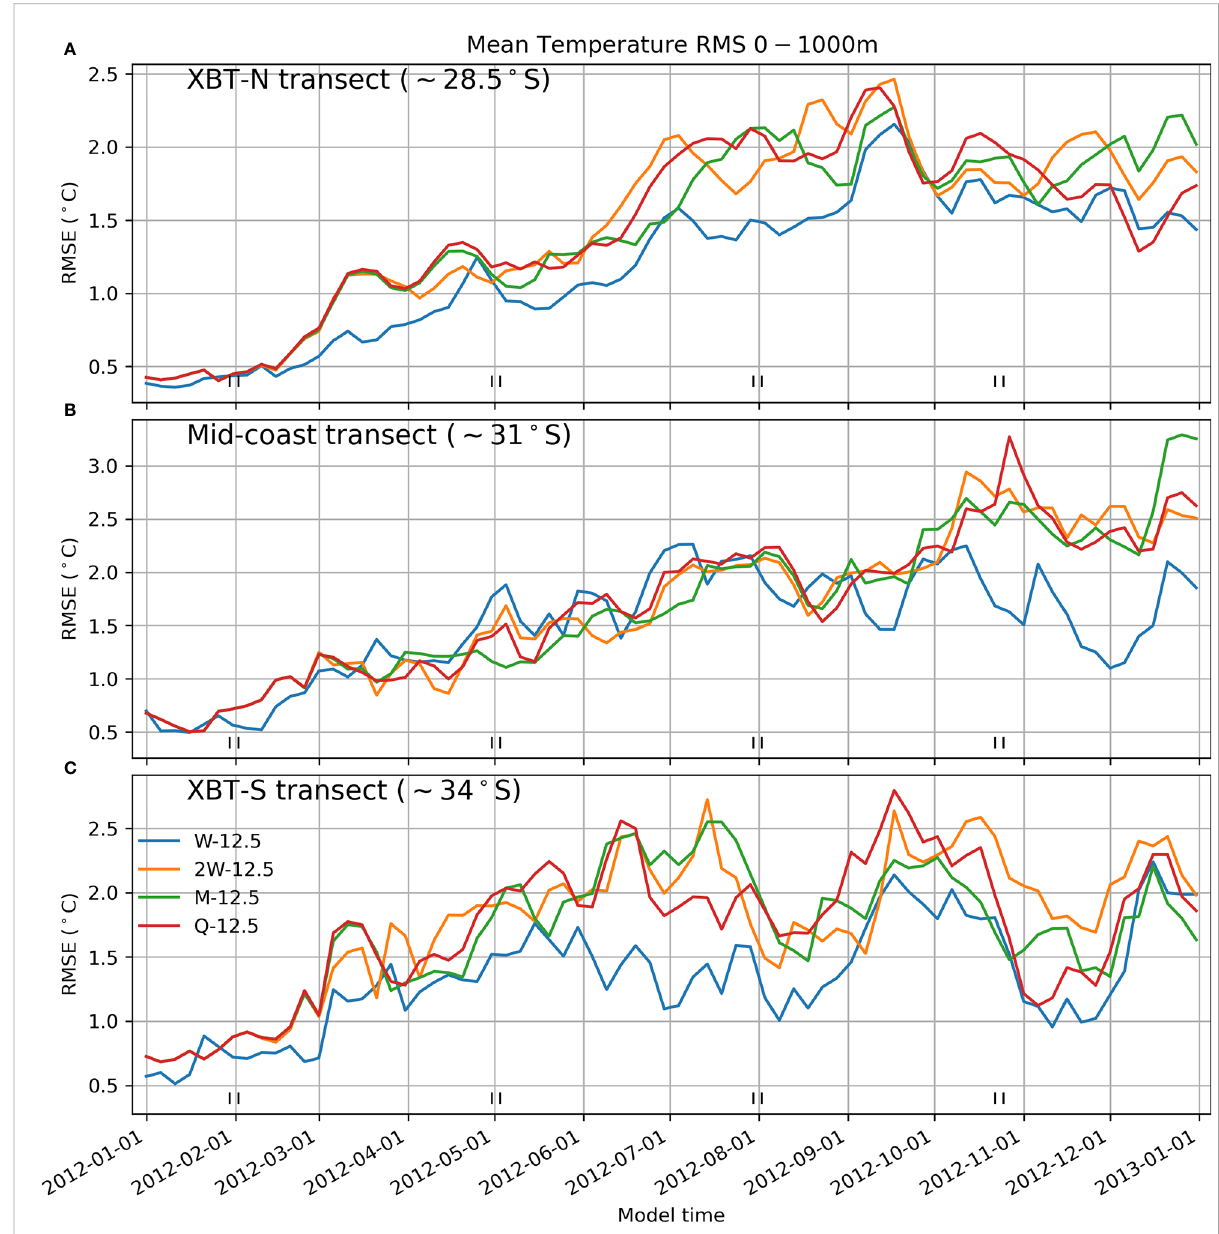
FIGURE 5 The transect-mean RMS error in temperature for (A) the XBT-N transect at ~28.5°S, (B) the mid-coast analysis transect at ~31°S and (C) the XBT-S transect at ~34°S for the four different OSSEs. RMS error compares the spatial-mean difference in temperature between each OSSE and the ref state. Black ticks indicate timings of quarterly XBT data assimilated into the Q-12.5